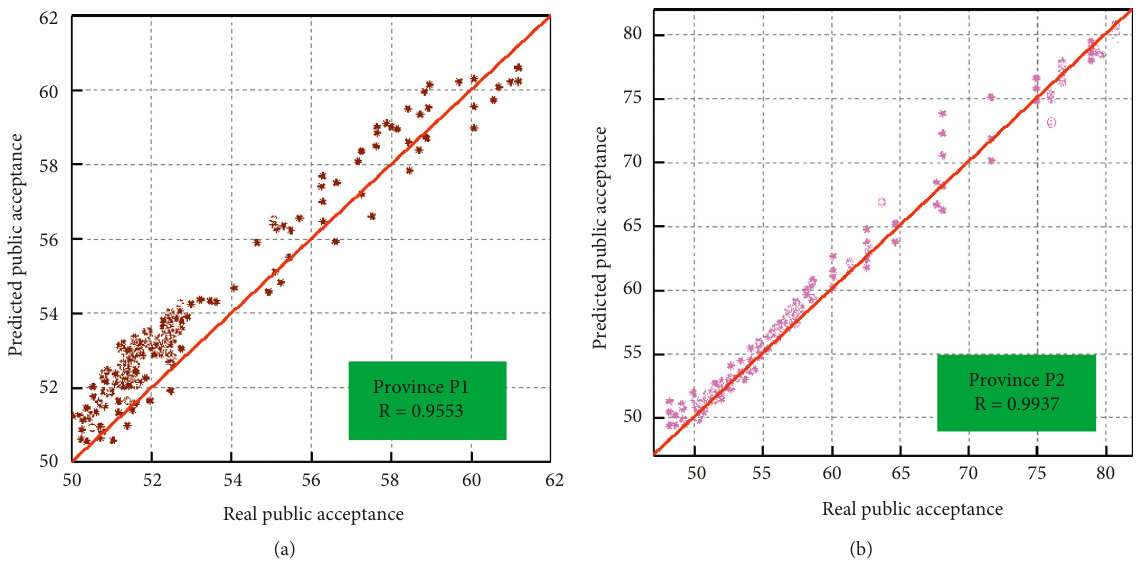
Figure 12: Linear correlation results of the predicted and real public acceptance in two provinces: (a) province � “ P 1;” (b) province � “ P